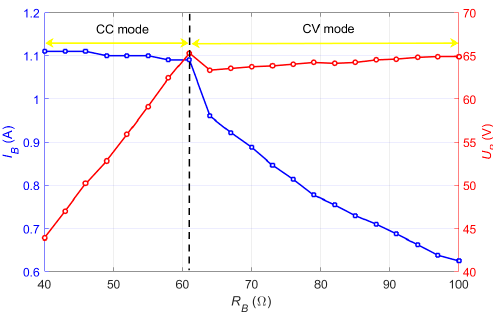
in , u B and i B from CC mode to CV mode.